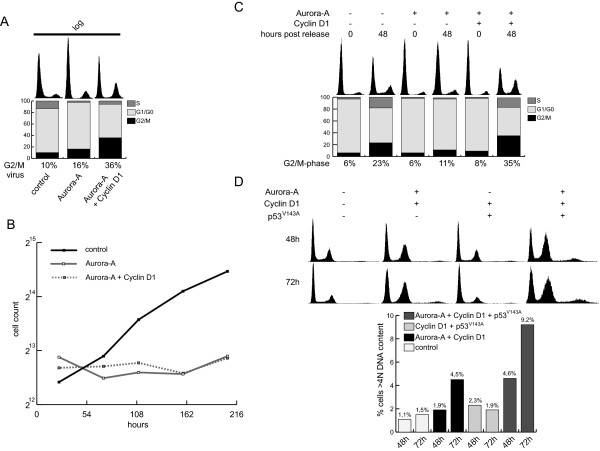
Long term effects of Aurora-A and Cyclin D1 co-expression. (A) Logarithmically growing Wi-38 cells were infected with the adenoviruses indicated. Three days after infection, cells were analyzed by PI-staining. One of two data sets is presented. (B) A growth curve experiment was performed with logarithmically growing Wi-38 infected with the viruses indicated. Data of two independent experiments are shown. (C) Serum starved Wi-38 cells were infected with adenoviruses expressing control (lacZ), Aurora-A, Cyclin D1 or a combination of these proteins. Cells were induced by serum addition and analyzed by PI-staining after 48 hours. A representative of three experiments is depicted. (D) Wi-38 cells were treated as in (C), but infected with the indicated combinations of Aurora-A, Cyclin D1 and p53V143A expressing adenoviruses. After 48 and 72 hours, cells were analyzed by PI-staining. Bars depict the percentage of cells with a DNA content >4N. A representative of two experiments is shown.